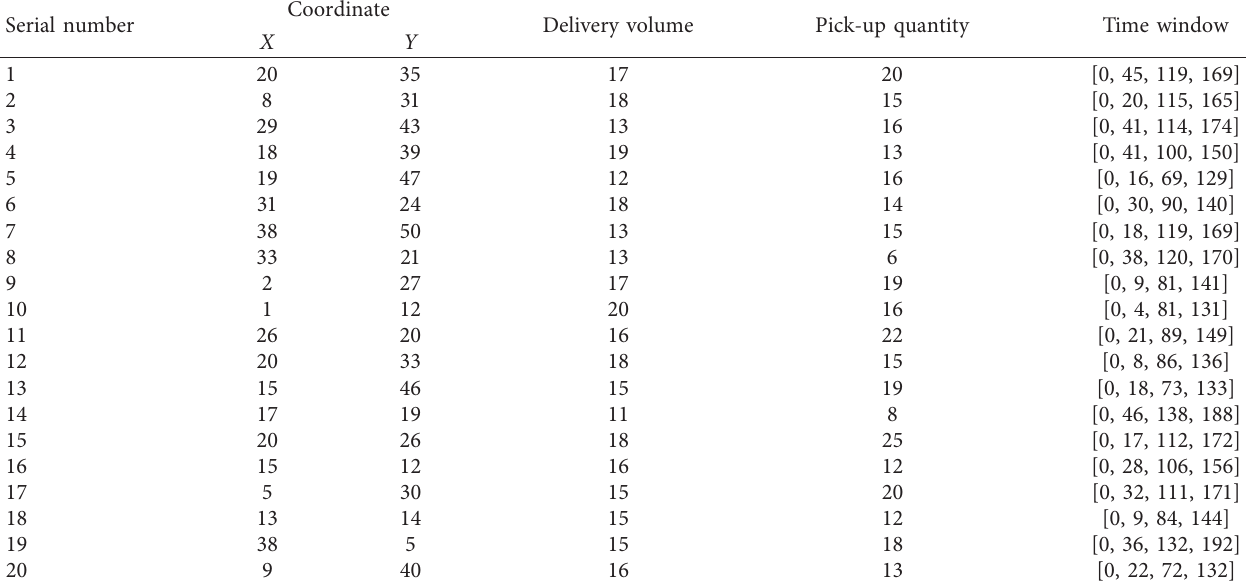
Table 5: Customer point information.